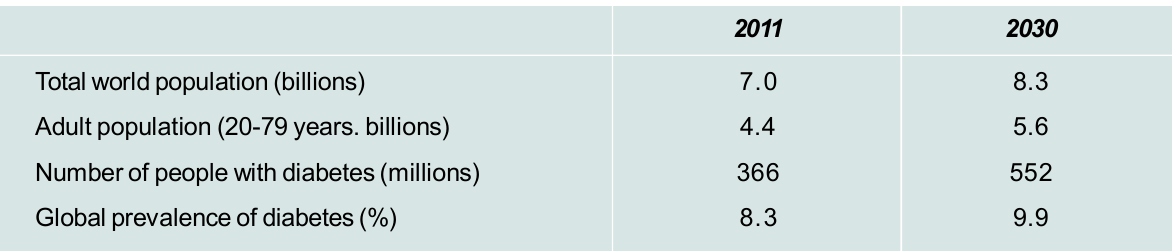
Table 1. Global prevalence of diabetes (2011 and 2030)